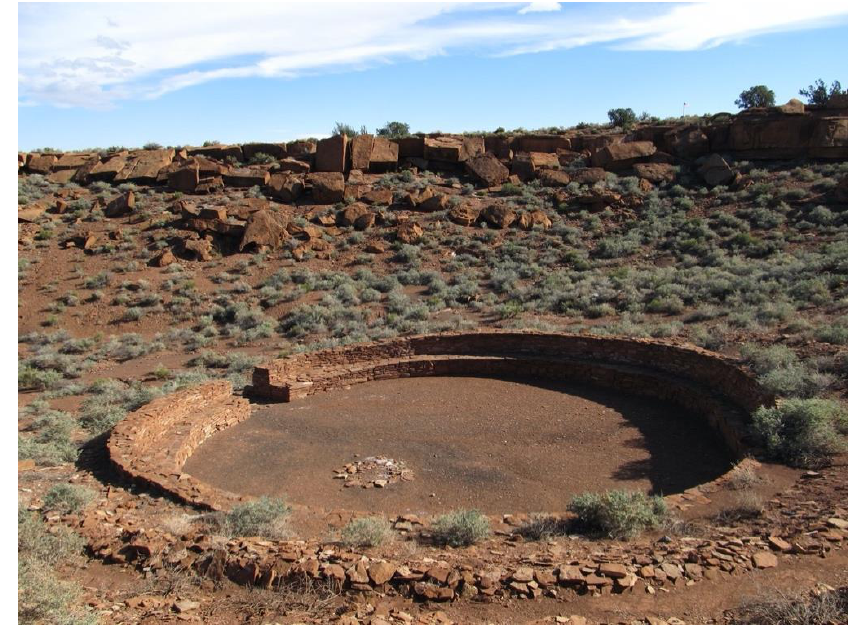
Figure 11. Ball court and ceremonial gathering area at Wupatki [48].